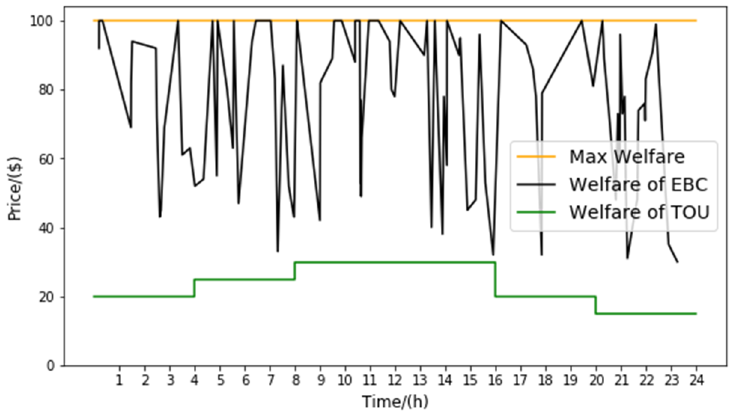
Figure 8. Social welfare.